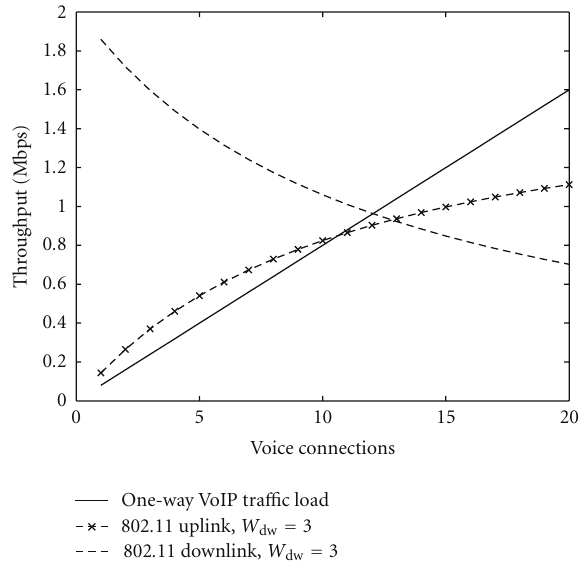
Figure 9: The throughput performance for the scheme without collaboration.